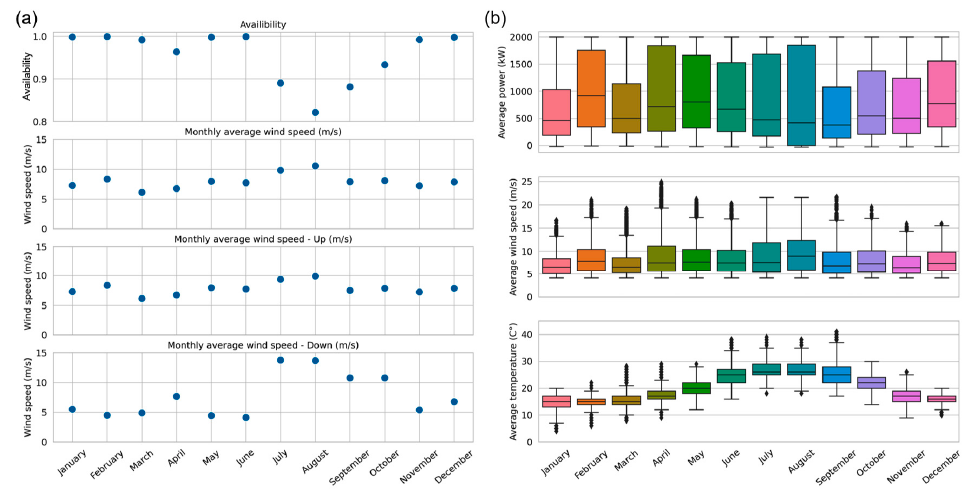
Figure 3. Monthly averages of measurement data for WT07 in 2016: ( a ) averages of availability, wind speed, wind speed during turbine uptime and wind speed during turbine downtime; ( b ) box plots of power, wind speed and temperature, where the centre lines show the median, the edges of the boxes the 25th percentile, the outer bars the 95th percentile and the points the outliers beyond